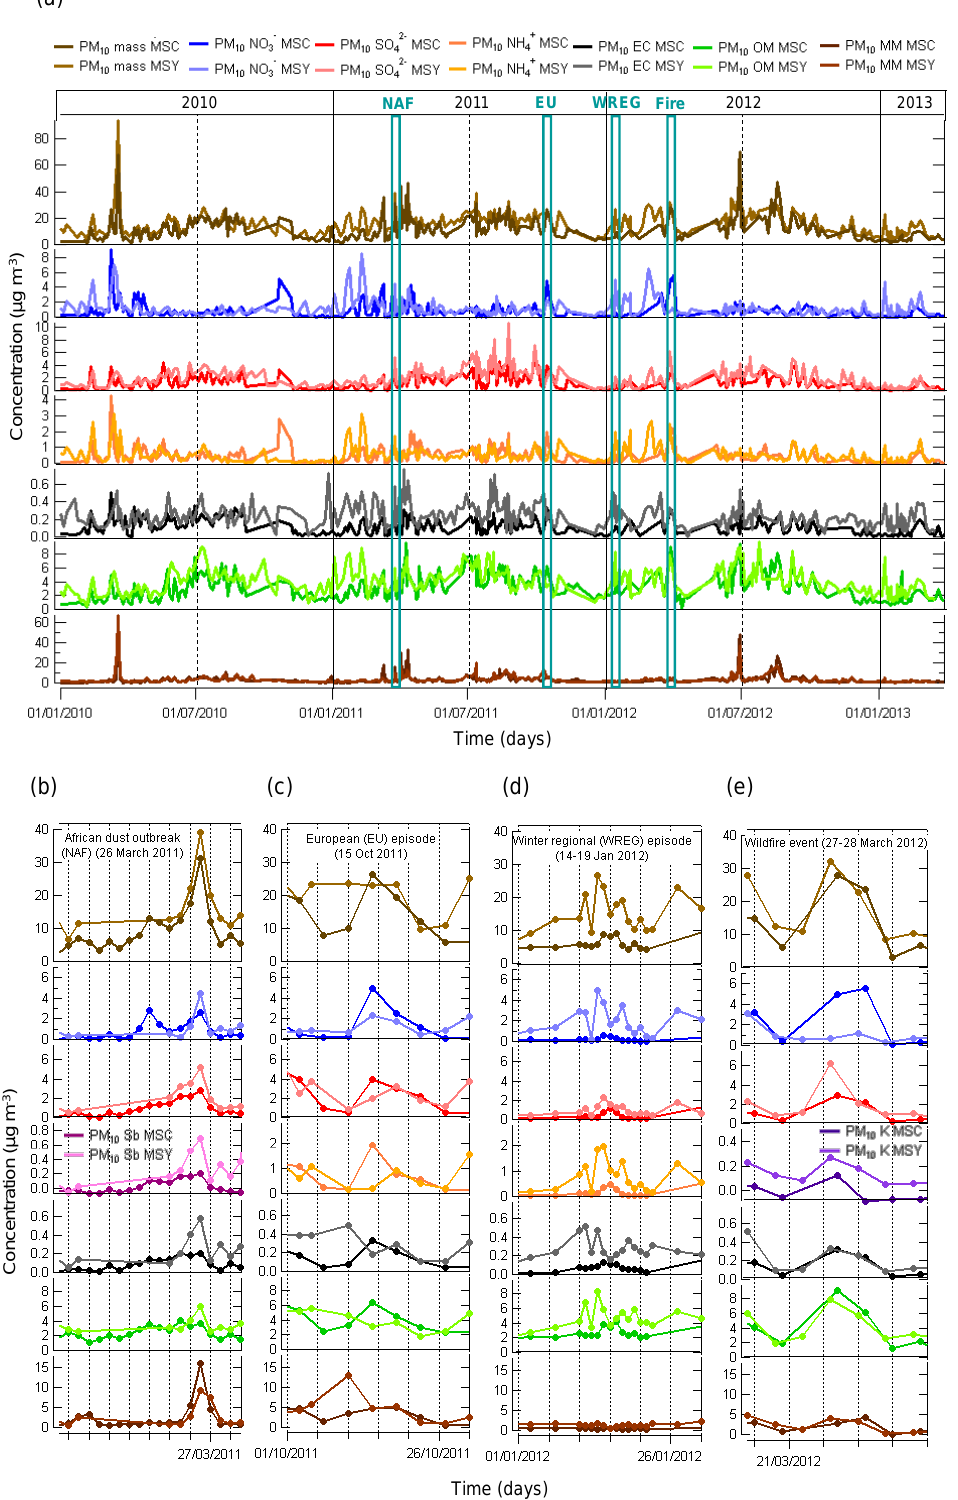
Figure 5. (a) Time series of daily PM 10 mass and major PM 10 chemical components concentrations at Montsec (MSC) and Montseny (MSY) between January 2010 and March 2013. Green bands indicate four examples of different episodes affecting the study area. Zoom of the four selected meteorological episodes – (b) African dust outbreak, (c) European episode, (d) winter regional episode, and (e) wildfire event – with daily PM 10 mass and PM 10 chemical components